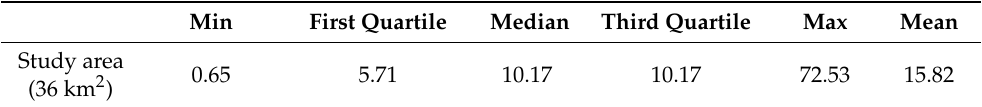
Figure 7. ( a ) DSs resolved correctly by the BA and DSMA methods in their respective culvert-modified DEMs. ( b , c ) DSs resolved correctly using the DSMA-based DS data (TP, yellow line) and FN (blue line) for the BA method in Case-1. Table 3. Positional accuracies of mapped DSs using the DSMA, as evaluated by Wang and Fareed for the study area